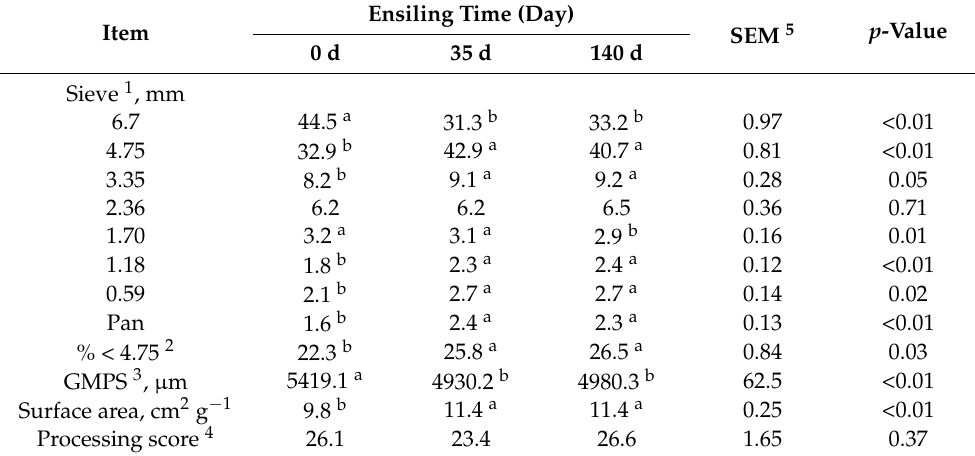
Table 5. Effect of ensiling time on kernel fraction particle size distribution, geometric mean particle size, surface area and processing score in whole-plant corn silage harvested with a pull-type forage harvester.